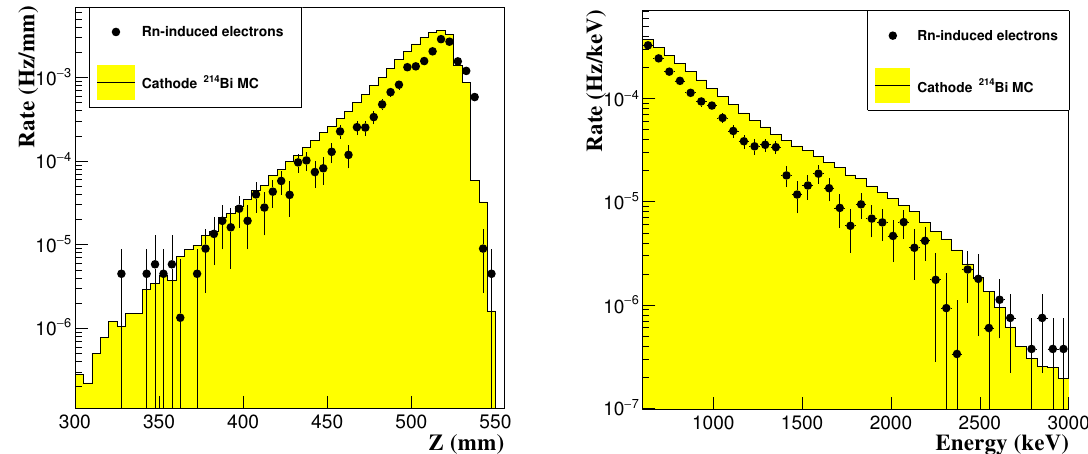
Figure 9 . Radon-induced electrons originating from the cathode (black dots) superimposed on the MC expectation (yellow histogram), as a function of the reconstructed Z coordinate (left panel) and reconstructed energy